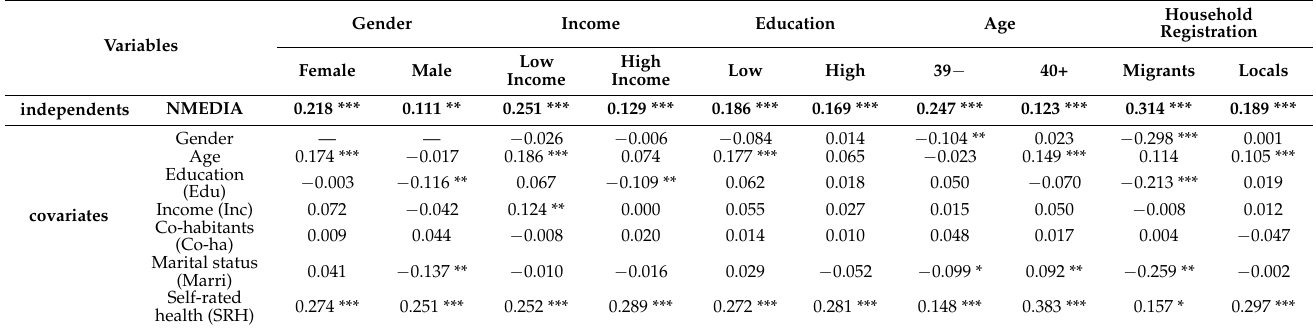
Table 6. Comparison of path coefficients of different group